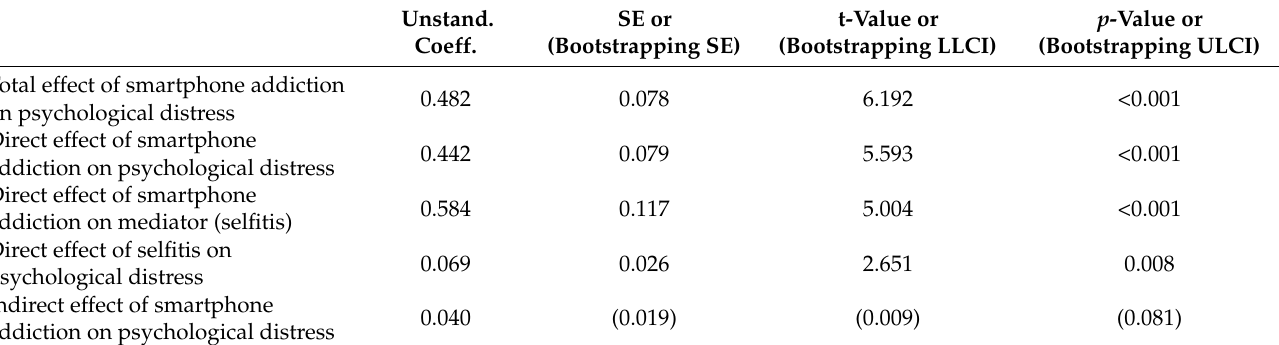
Table 4. Models of the effect of problematic smartphone use on psychological distress with selfitis as the mediator.